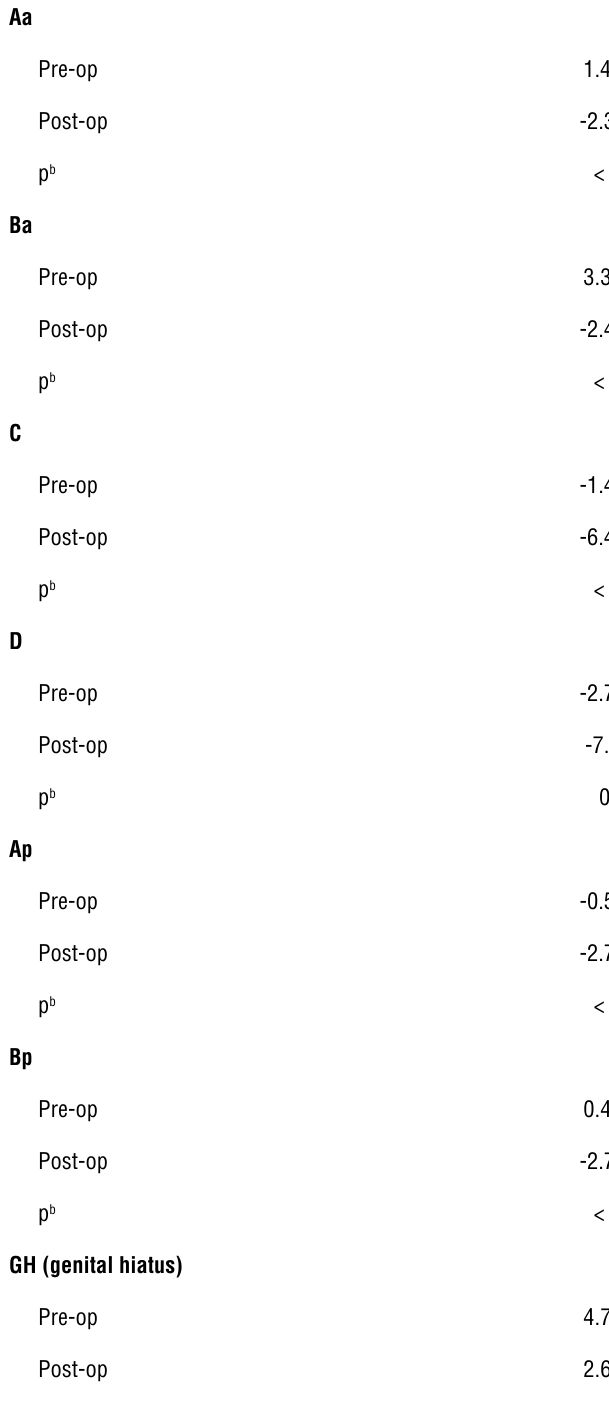
Table 2 - POP-q measurements in centimeters ± standard deviation (SD) at pre and postoperatory periods from Mesh and Control groups Aa Pre-op 1.47 (1.61)